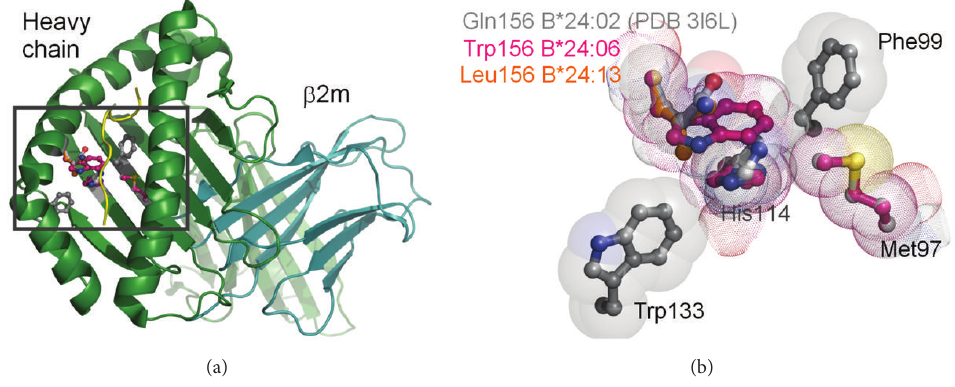
Figure 8: Representation of the 97/114/156 residue triad. Ribbon representation of the HLA-A ∗ 24:02 structure (PDB 3I6L) [29], HLA hc (green) and b2m (turquoise) and peptide (yellow); residues 97, 99, 114, 133, and 156 are drawn as ball and stick (a). A magnified view of the residues highlighted in (a); the HLA hc, b2m, and peptide have been removed for clarity (b). The residue triad Met97/His114/Gln156 from the HLA-A ∗ 24:02 structure is shown as ball and stick with a transparent van der Waals surface (grey). The HLA-A ∗ 24: 06 156 Trp (pink) or HLA-A ∗ 24: 13 156 Leu (orange) polymorphisms, depicted as a dotted van der Waals surface, show increased energetically stability provided by improved packing between the triad residues and aromatic residues Phe99 and